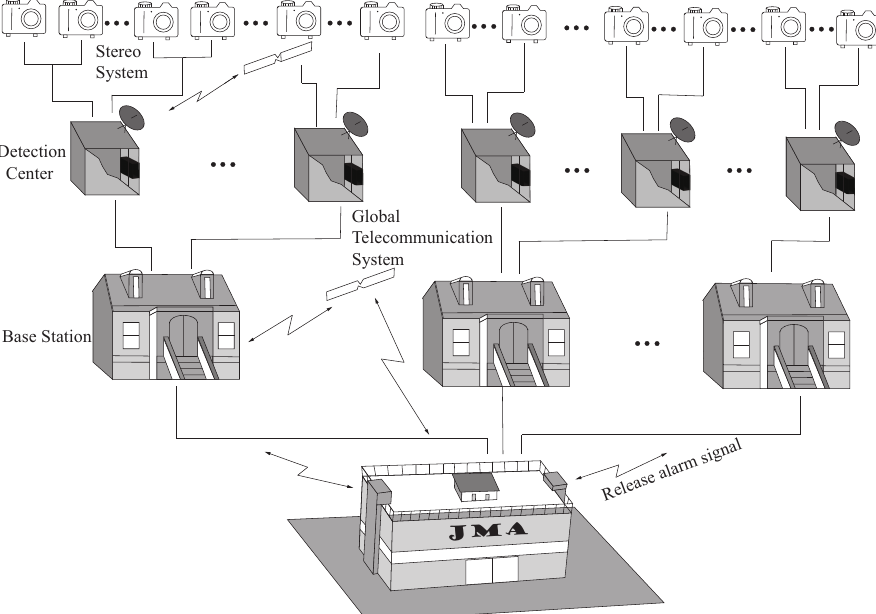
Figure 1. Scheme of proposed sea level monitoring system (on the left is the schematic diagram and on the right is the main equipment of the proposed